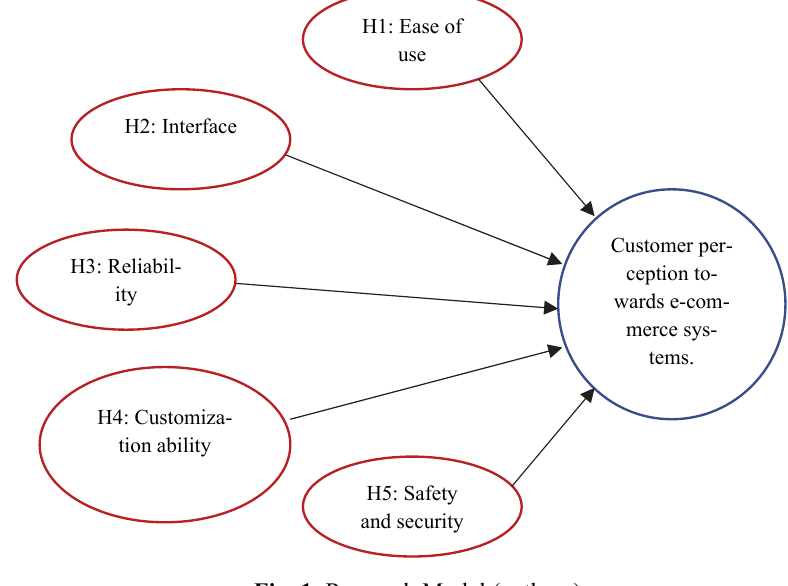
Fig. 1. Research Model